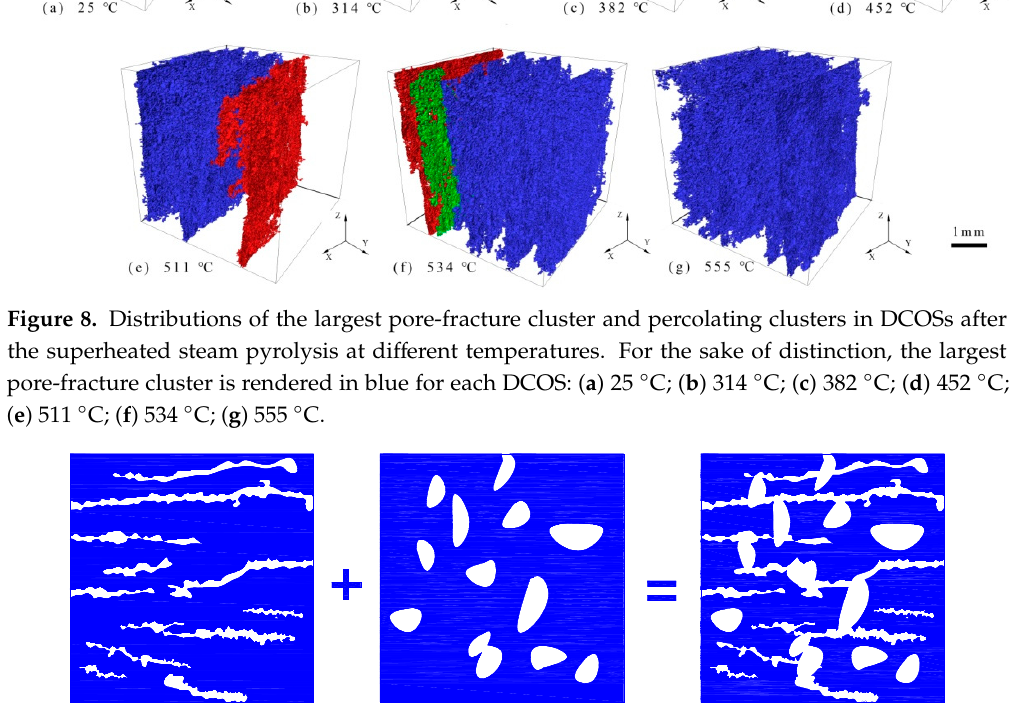
Figure 9. Schematic diagram of the formation of the sizeable pore-fracture cluster by the interconnection of smaller pores and fractures.